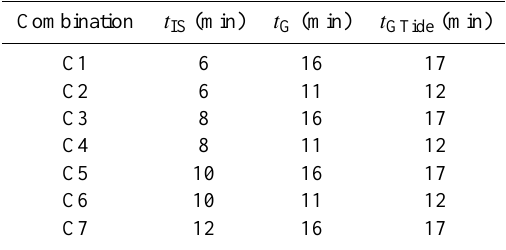
Table 4. Combinations of the temporal parameters t IS , t G , and T GTide . We recall that in this work, t BS , t Tide , and t sm are kept constant and equal to t BS = t Tide = 60min and t sm =